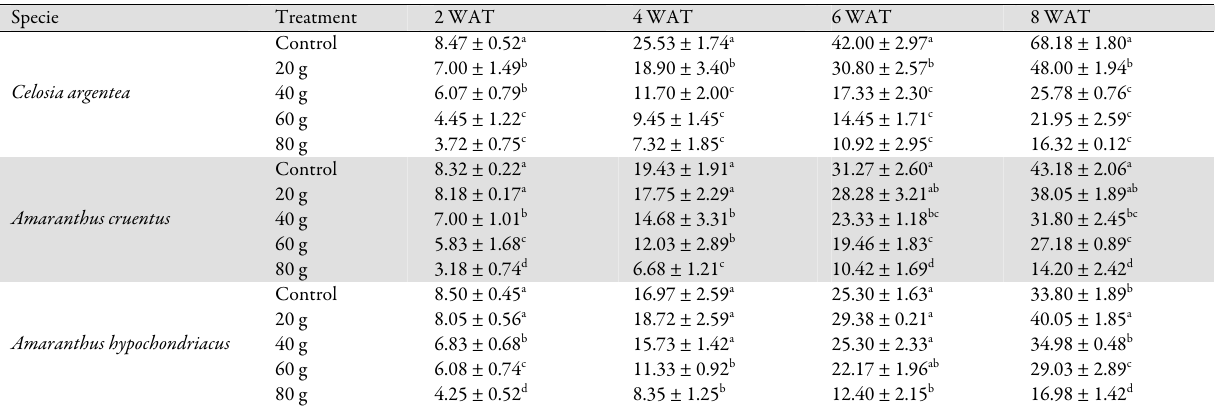
Table 1. Mean plant height of the studied leafy vegetables to the allelopathic effect of Vitellaria parodoxa leafs Specie Treatment